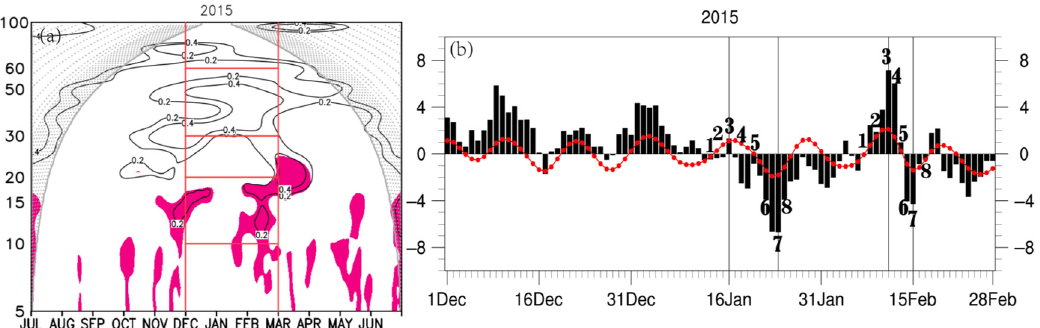
Figure 3. ( a ) Wavelet analysis of the regional average minimum temperature series in northern China in 2015. The area between the vertical red lines represents the period from December to February (the shaded contour encloses regions of larger than 0.1 significance), and the horizontal red lines correspond to 10, 20, 30, and 60 d, respectively. ( b ) Minimum temperature departure series (bar) and its 10–20 d component (curve). The interval between the two vertical lines denotes the strong cooling process (unit: °C).